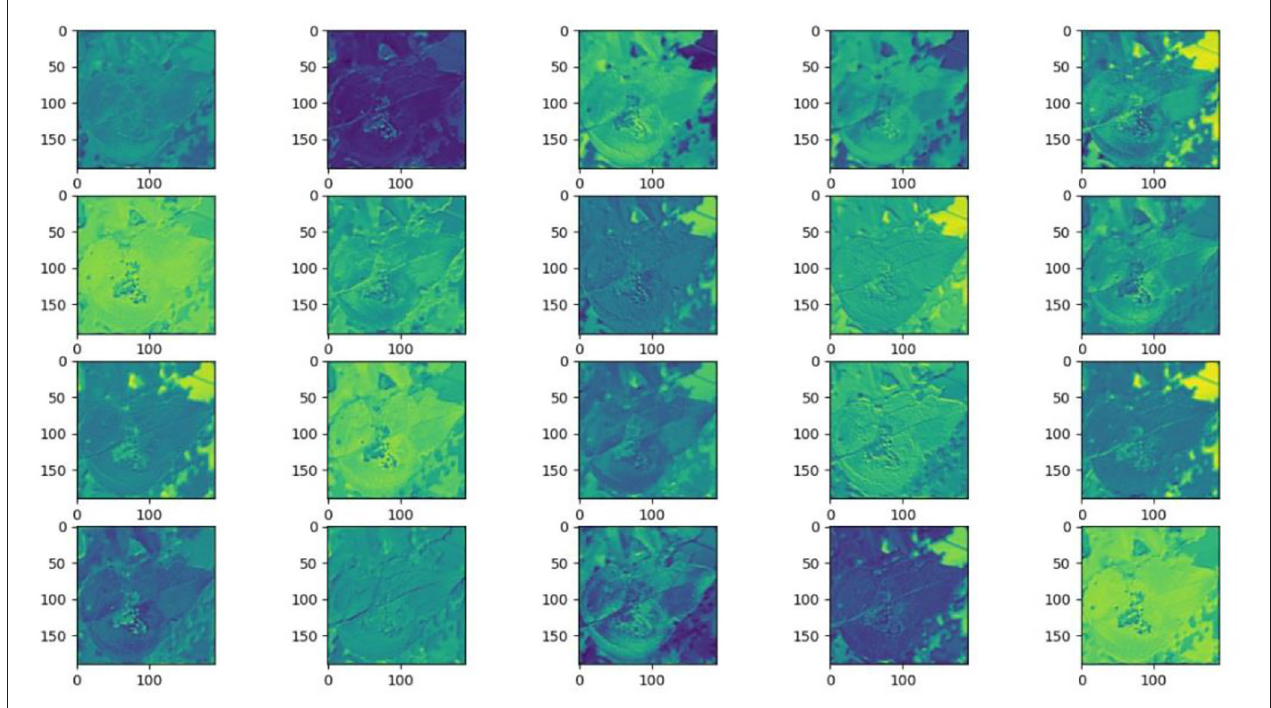
FIGURE 8 | Partial output feature maps of the first CA-Conv.